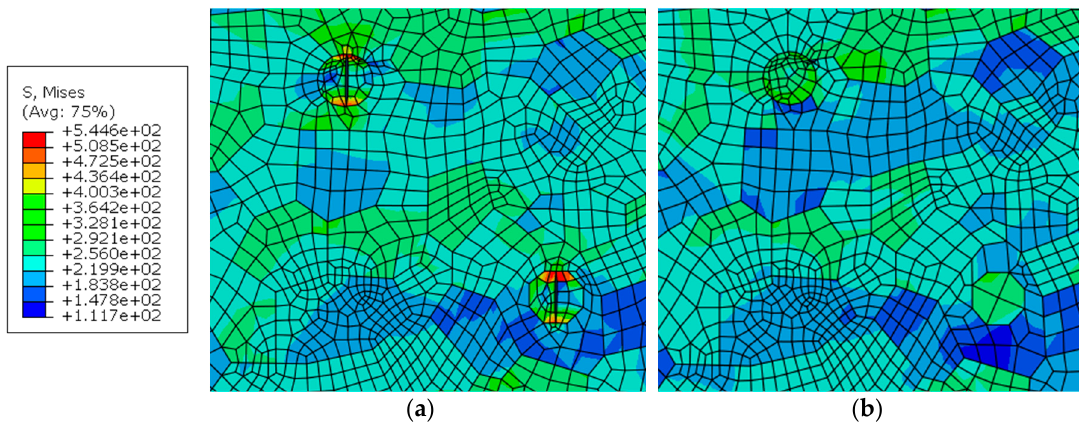
Figure 19. Distribution of von Mises equivalent stress in the WNZ of including ( a ) cracked particles and ( b ) uncracked particles, MPa.